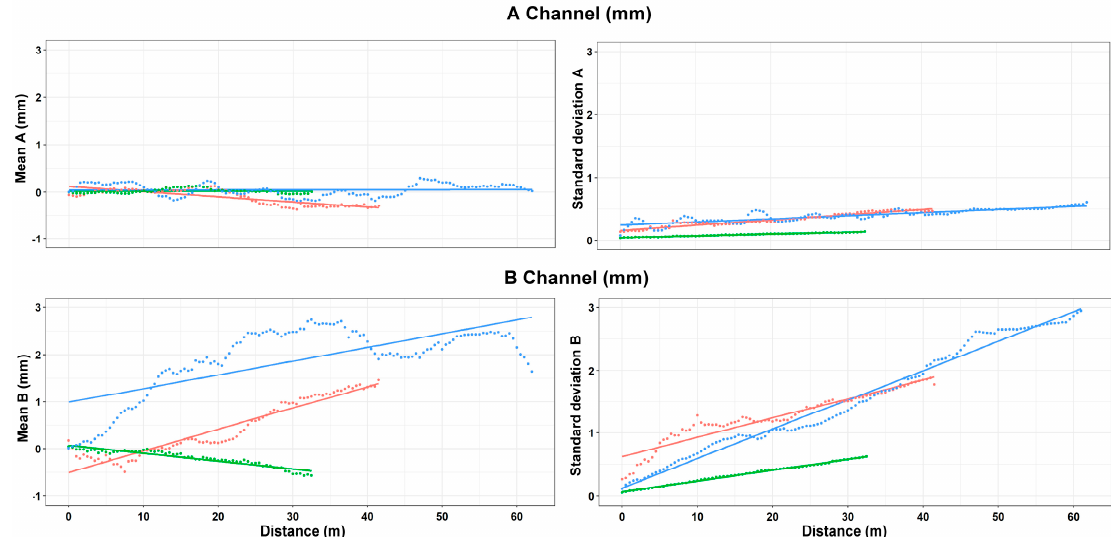
Figure 15. Cumulative displacements for each channel (upper frame channel A, lower frame channel B) in relation to distance from the toe of the borehole: ( a ) Section 1—62.5 tube length; ( b ) Section 2— 42.5 tube length; and ( c ) Section 3—33.5 tube length. The grey area shows the error interval (RMS).